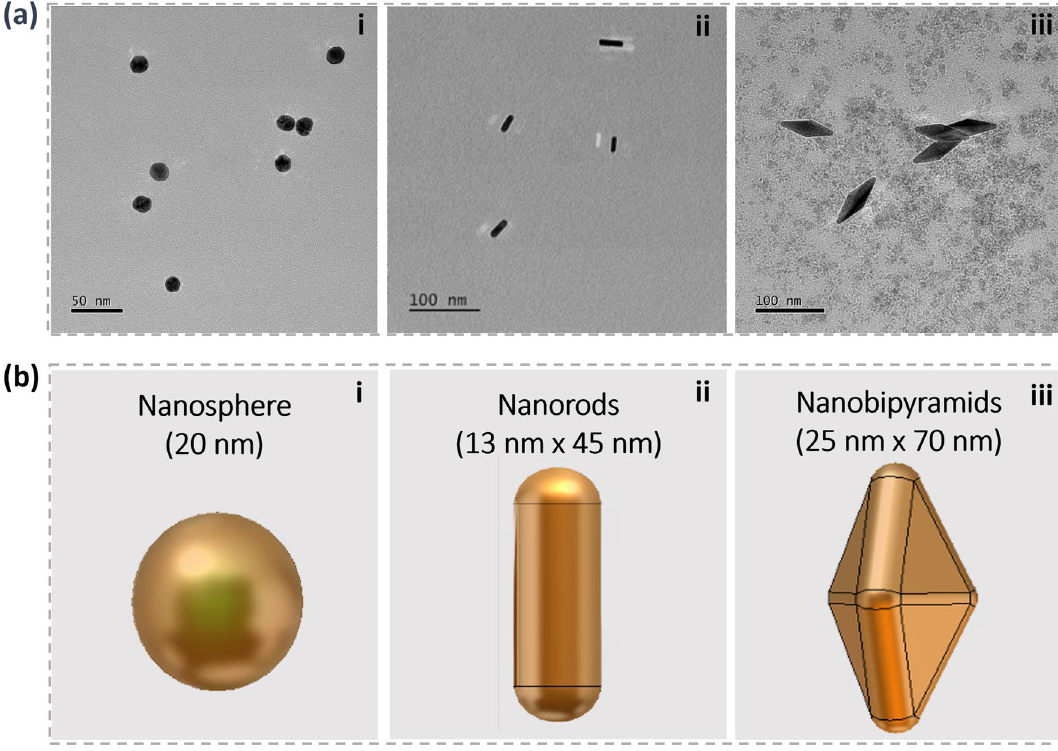
Figure 3. Synthesized nanoparticles and modeled geometries. ( a ) TEM micrographs of the synthesized (i) nanospheres, (ii) nanorods, and (iii) nanobipyramids. ( b ) Dimensions and schematics of the modeled nanoparticles in accordance to the synthesis.